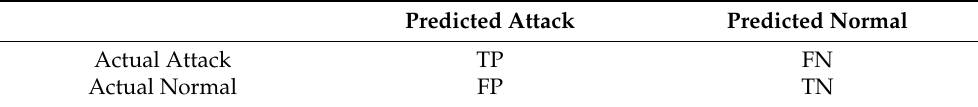
Table 4. Confusion